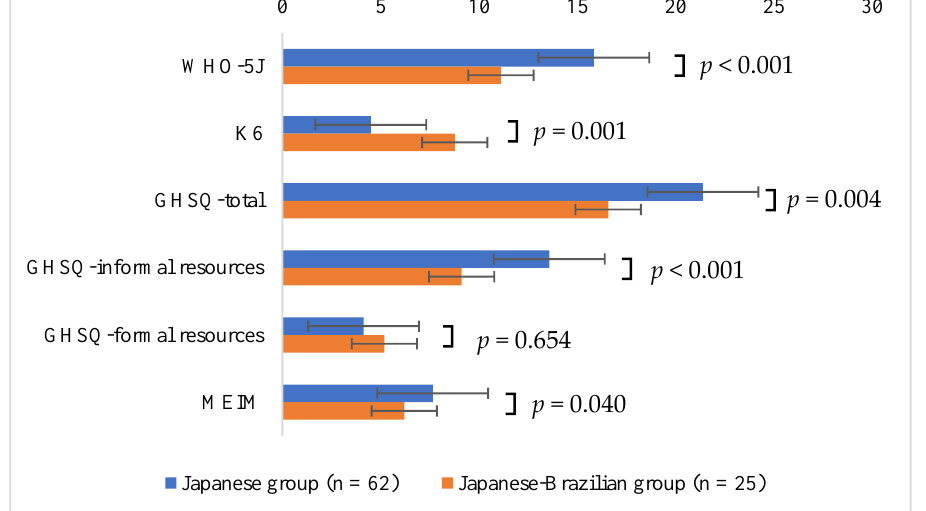
Figure 1. Comparisons of WHO-5J, K6, and GHSQ results between Japanese and Japanese–Brazilian high school students. WHO-5J: the WHO-Five Well-being Index, K6: the Kessler 6 scale, GHSQ: the General Help-Seeking Questionnaire, MEIM: the Multigroup Ethnic Identity Measure.